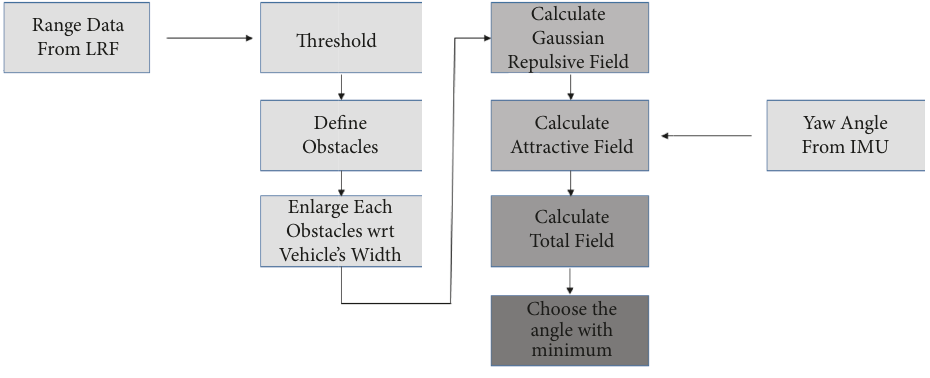
Figure 5: Flowchart of ODG-PF.